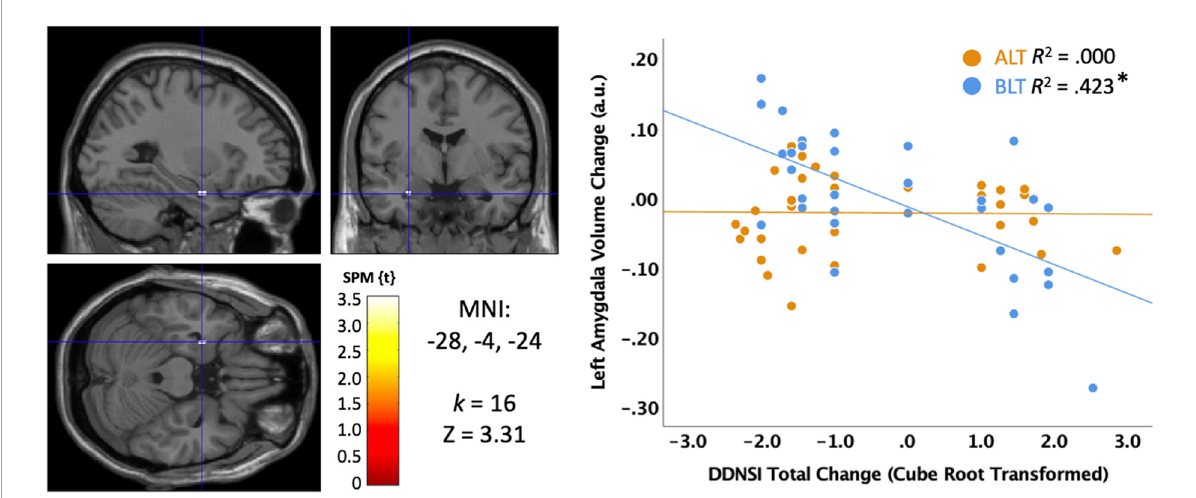
FIGURE8 Correlation between sleep quality change on the Disturbing Dream and Nightmare Severity Index (DDNSI) and the change in left amygdala volume after 6 weeks of treatment with blue light treatment (BLT) or amber light treatment (ALT). The left panel shows the location of the significant cluster in the amygdala for the entire sample, p < 0.05 FWE cluster corrected. The right panel shows the scatterplot for the BLT and ALT samples separately. DDNSI change data were cube root transformed to ensure assumptions of normality. MNI, Montreal Neurologic Institute stereotaxic coordinates. *p <